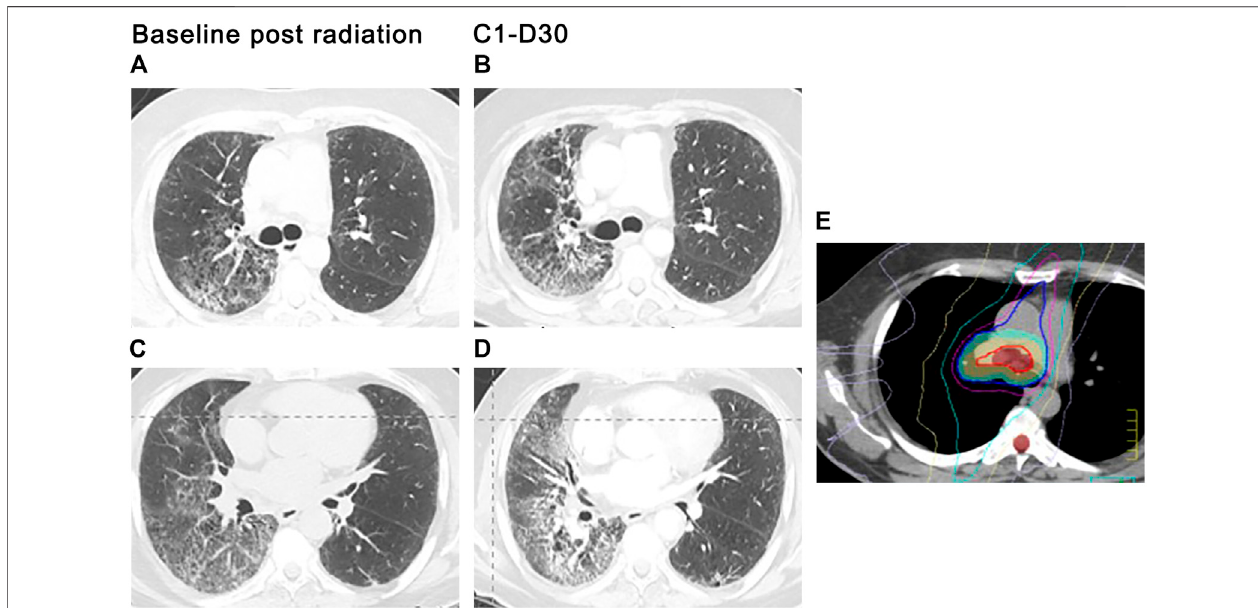
FIGURE 4 | ICI-related radiation recall. A 56-year-old man with metastatic adenocarcinoma of the lung presented with severe shortness of breath and dry cough 3.5 weeks after the fi rstcycle ofpembrolizumabfor metastatic adenocarcinoma. Radiationtherapy tothe rightchestwascompleted 13 months prior. Stable subpleural reticular opacities associated with traction bronchiectasis are seen on the baseline CT and consistent with sequelae of prior radiotherapy (A,C) . Admitting CT scan demonstratednewgroundglassopacitiesintherightupperandlowerlobes (B,D) thatconformwiththepriorradiationportal (E) .Centrilobularemphysemaisagain seen. Findings suggest radiation recall precipitated by pembrolizumab